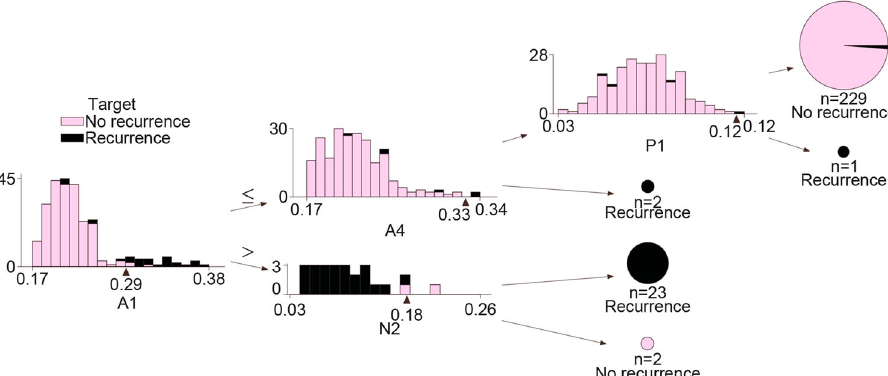
Fig. 10 Support to clinical decisions. Decision tree to assess patient recurrence based on spatial phenotype quanti fi cations. In each decision tree step (from left to right), an automatic threshold is set to divide patients with recurrence from those with no recurrence. Tissue area A1 ( “ nonin fl amed ” or “ cold tumors ” ) was the most relevant spatial feature to differentiate between tumors with recurrence from those with no